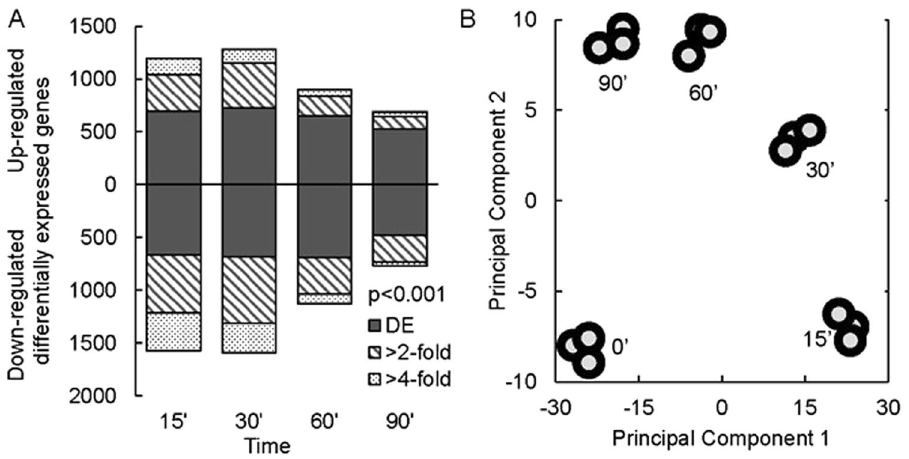
Figure 4. Time-dependent transcriptional response to osmotic shock of ethanol-growing yeast cells. ( A ) Number of significantly differentially expressed genes at the indicated time-points (adj. pval < 0.001). ( B ) Principal component analysis for every replicate